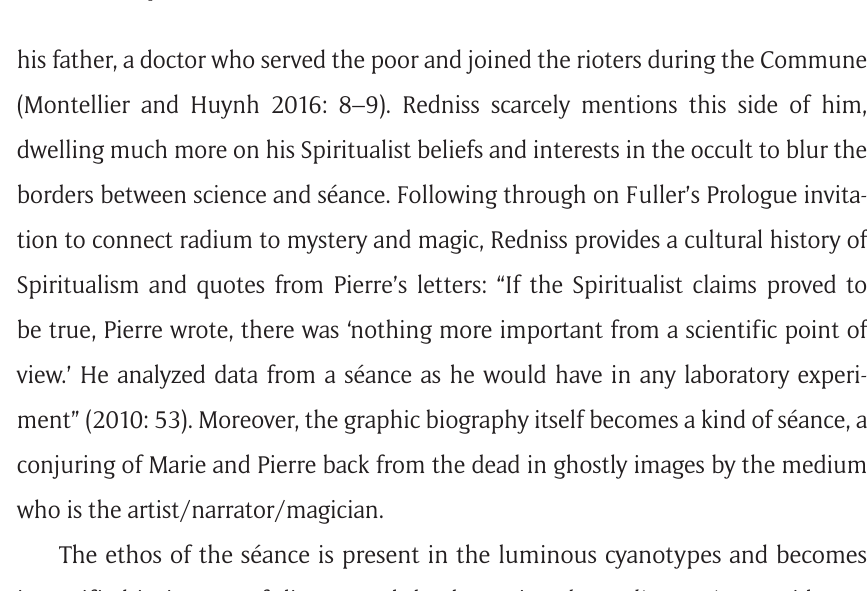
Figure 2: Pierre’s Death in Radioactive by Lauren Redniss, 2010: 96–7. © It Books/HarperCollins – Lauren